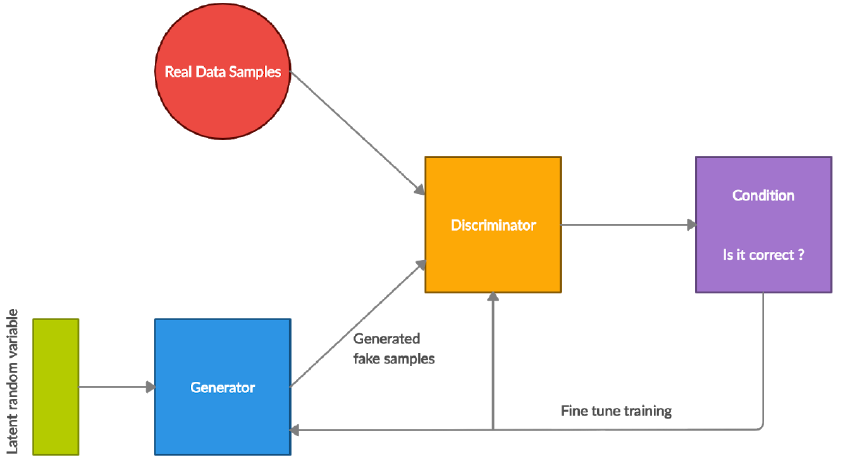
Figure 1. Working of